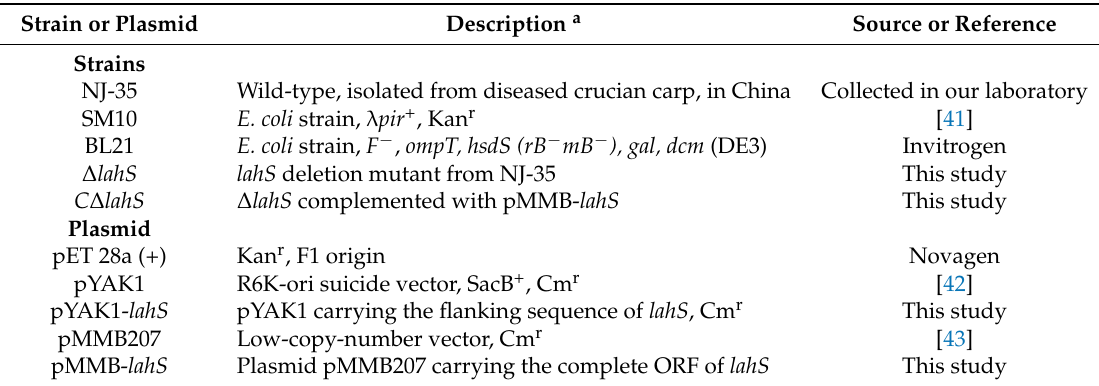
Table 3. Bacterial strains and plasmids used in this